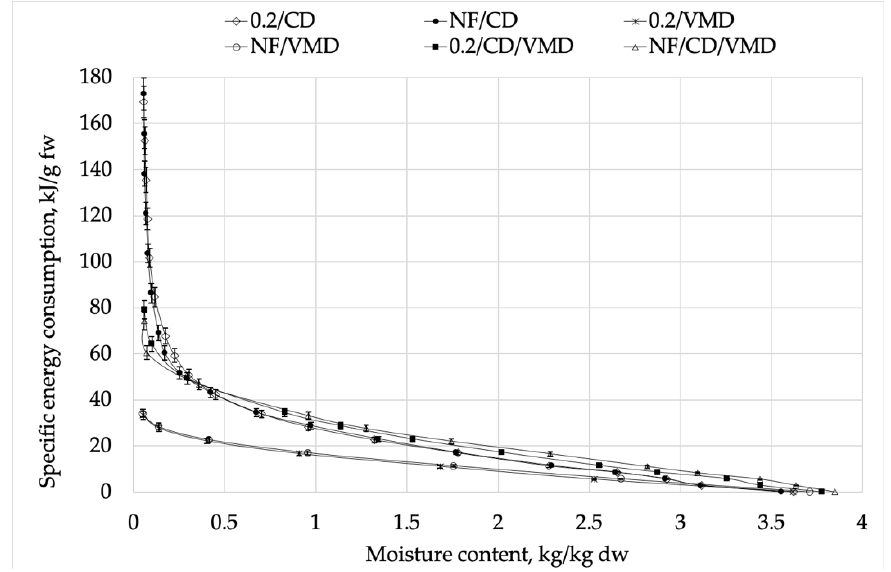
Figure 2. Specific energy consumption during drying using different methods.